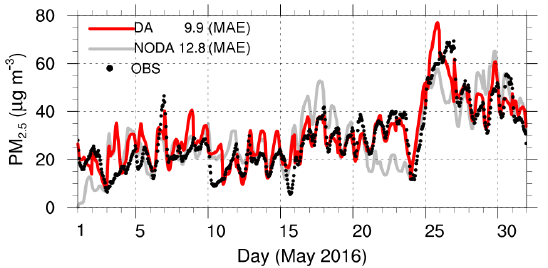
Figure 6. Time series of surface PM 2 . 5 simulated with (DA; red) and without assimilation (NODA; gray) in domain 2, represent- ing hourly 0–23h forecasts from 00:00UTC every day, as averages over 361 stations over South Korea. Corresponding observations are marked as black dots. The mean absolute error (MAE; | o–f | ) aver- aged over the entire period is shown for each experiment. Here, DA refers to the ALL